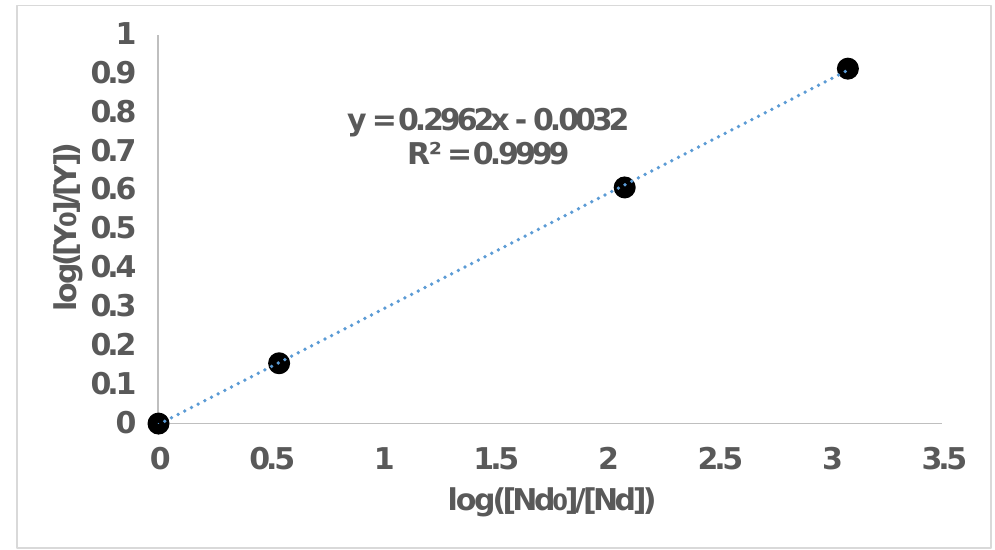
Figure 2. Enrichment of La against Y: logarithm of the quotient of the starting concentration and final concentration for each rare earth.